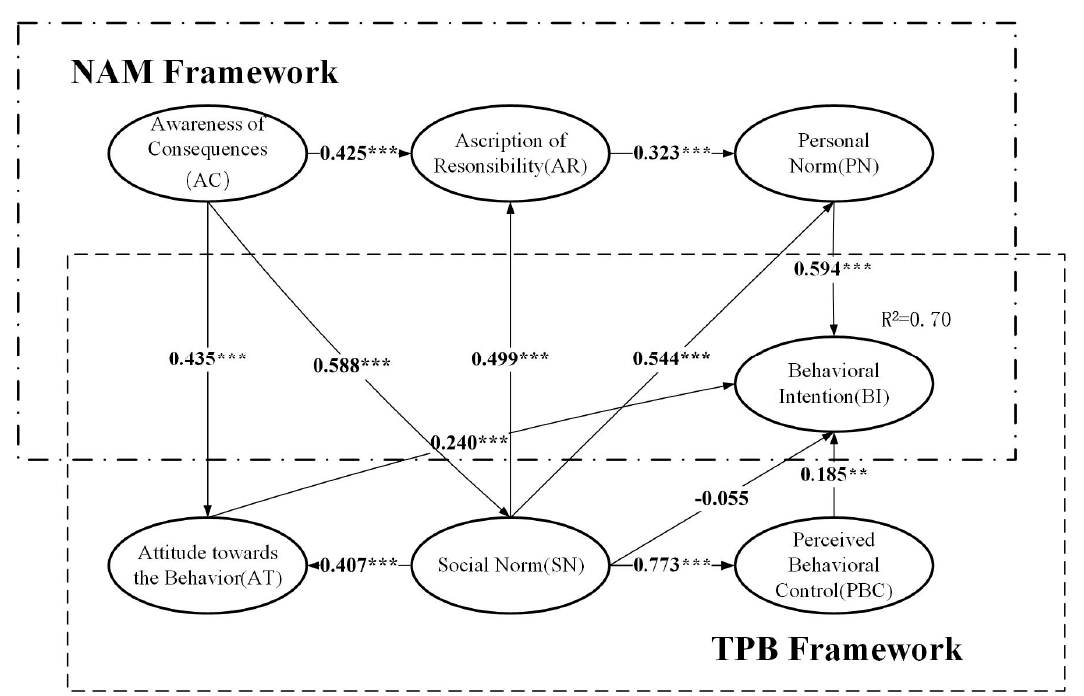
Figure 3. Results of model estimation. *** p < 0.01, ** p < 0.05.